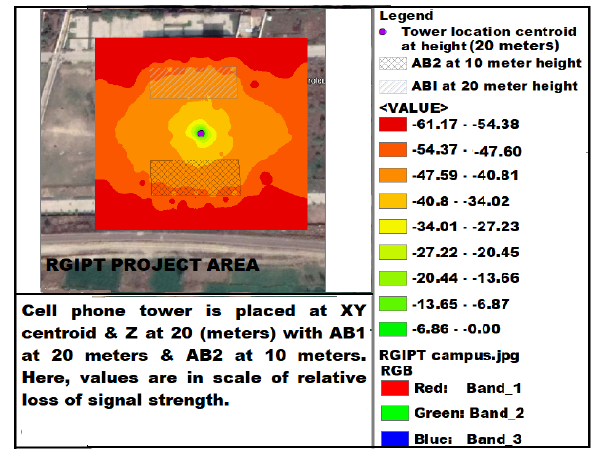
Figure 23. Cell phone tower at XY Centroid and Z at 20 meters when both building heights are different.